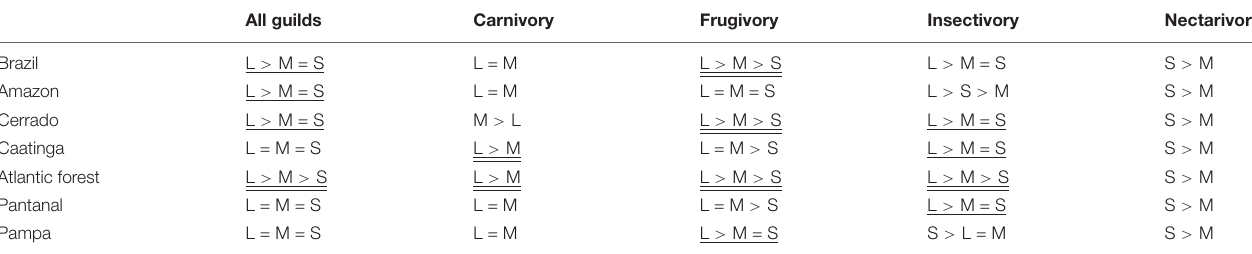
The “equal” symbol means no statistical difference between groups. The “greater than” symbol means a statistical difference for p < 0.05 (Nemenyi’s non-parametric test). Cells marked with double underline show the sequence of impacts according to our working hypothesis. Cells marked with single underline show the sequence of impact partially according to the working